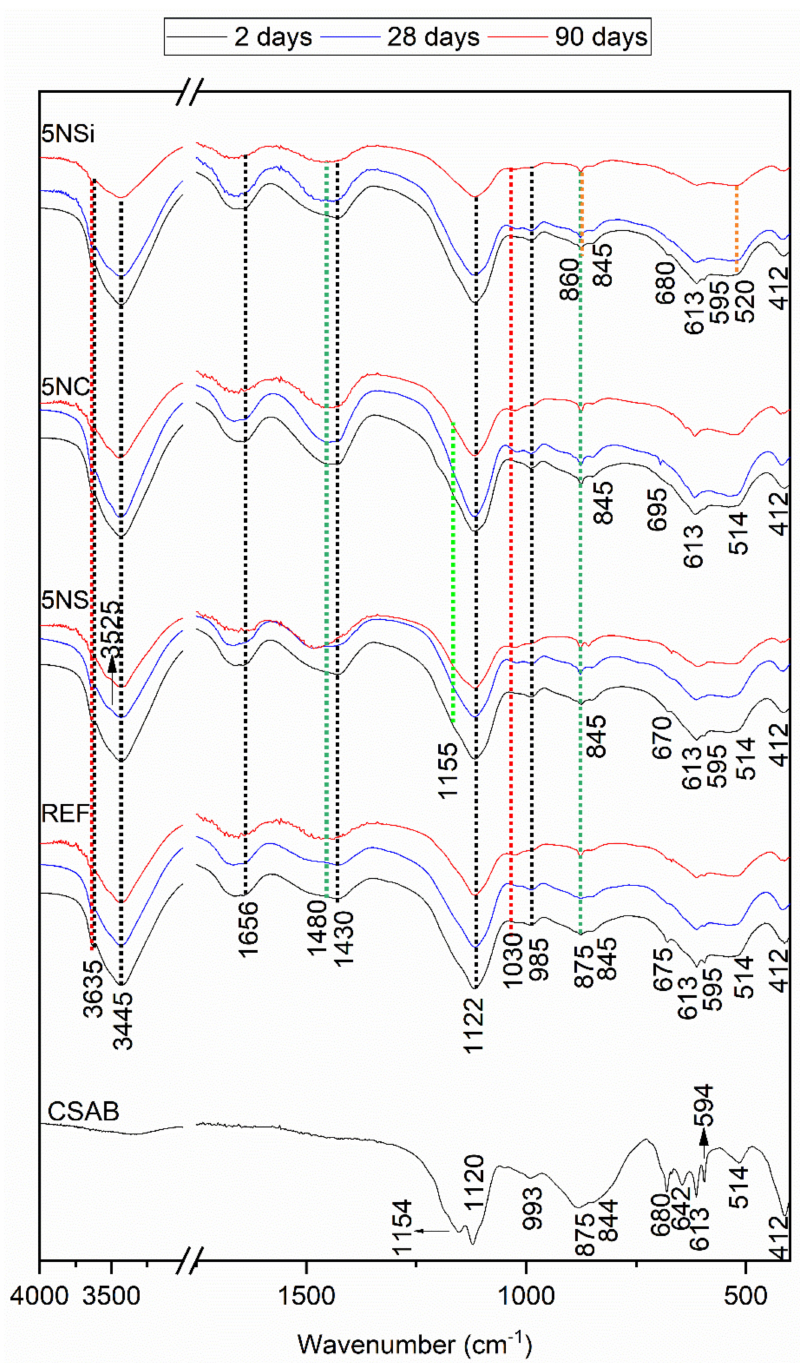
Figure 4. Two-day, 28-d and 90-d Fourier transform infrared spectroscopy, (FTIR) spectra for REF, 5NS, 5NC, and 5NSi pastes; legend: red line—AH 3 , black line—ettringite, green line—calcite, blue line: thenardite, orange